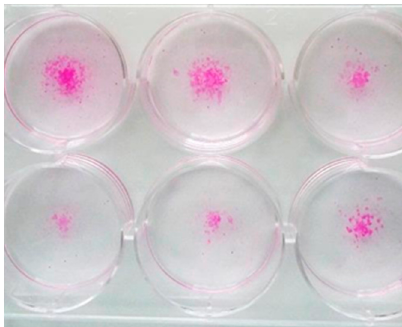
Figure 3. Inhibition of biofilm formation in % after 24 h incubation with 5, 10 and 20 µg/mL IgY1.